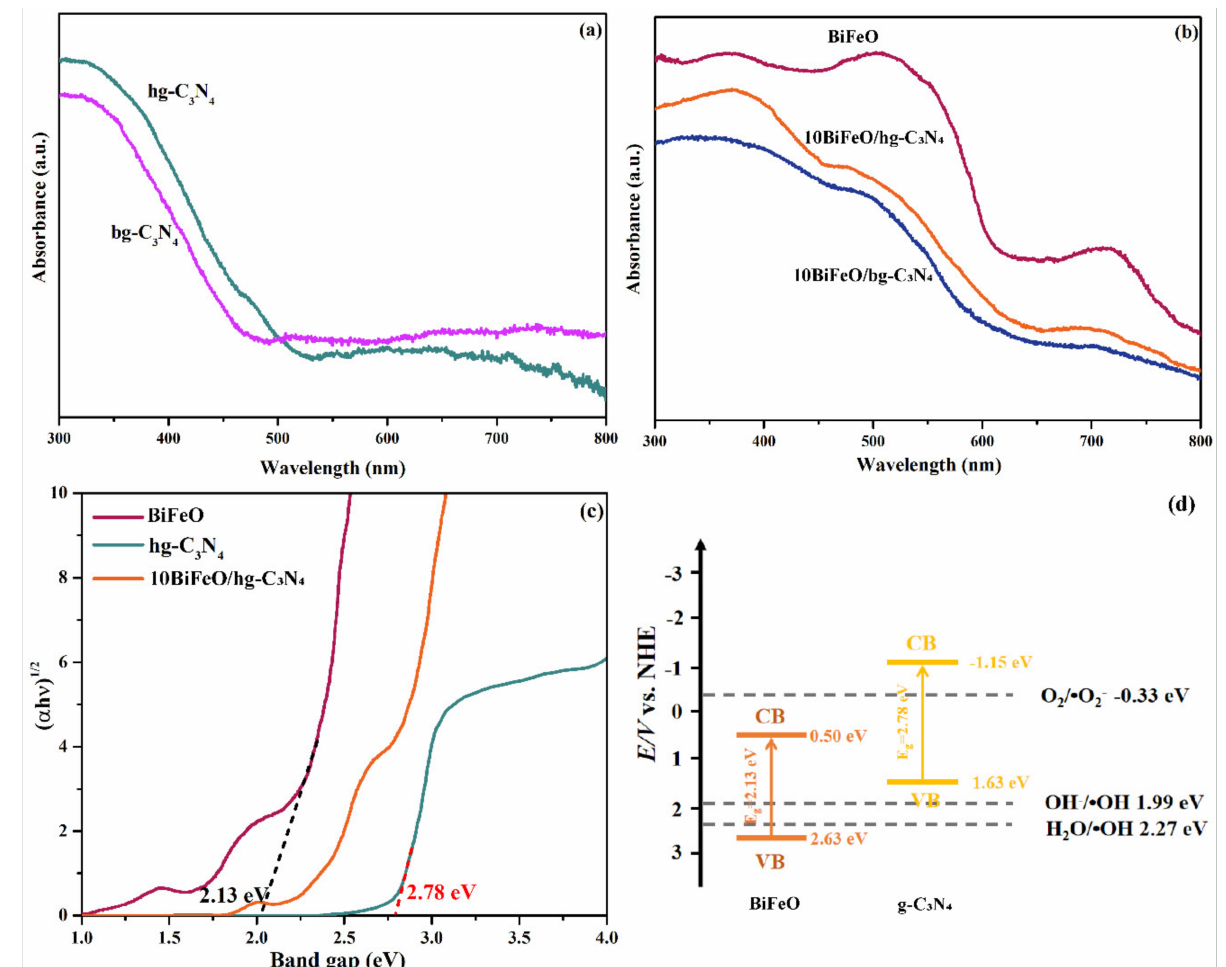
Figure 10. ( a ) UV-visible spectra of hg-C 3 N 4 and bg-C 3 N 4 ; ( b ) UV-visible spectra of BiFeO, 10BiFeO/hg-C 3 N 4 and 10BiFeO/bg-C 3 N 4 ; ( c ) estimated band gaps of BiFeO, hg-C 3 N 4 and 10BiFeO/hg-C 3 N 4 ; ( d ) band gap structure of 10BiFeO/hg-C 3 N 4